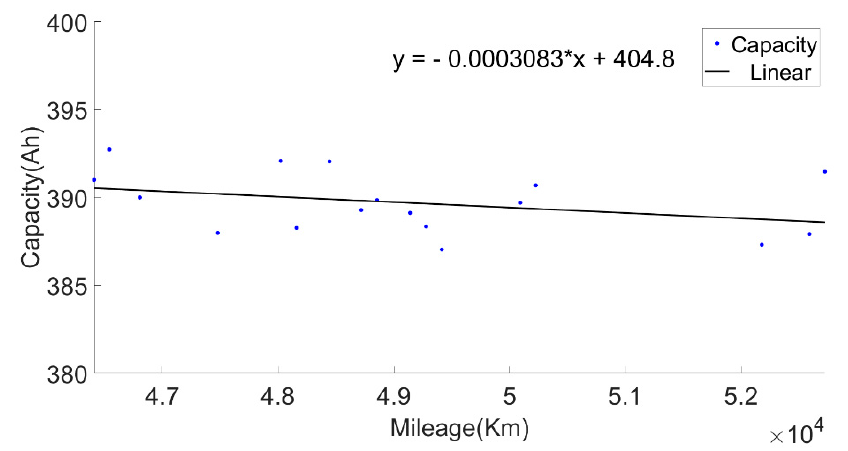
Figure 11. The relationship between the current capacity and the mileage at charging temperature of 23 °C.